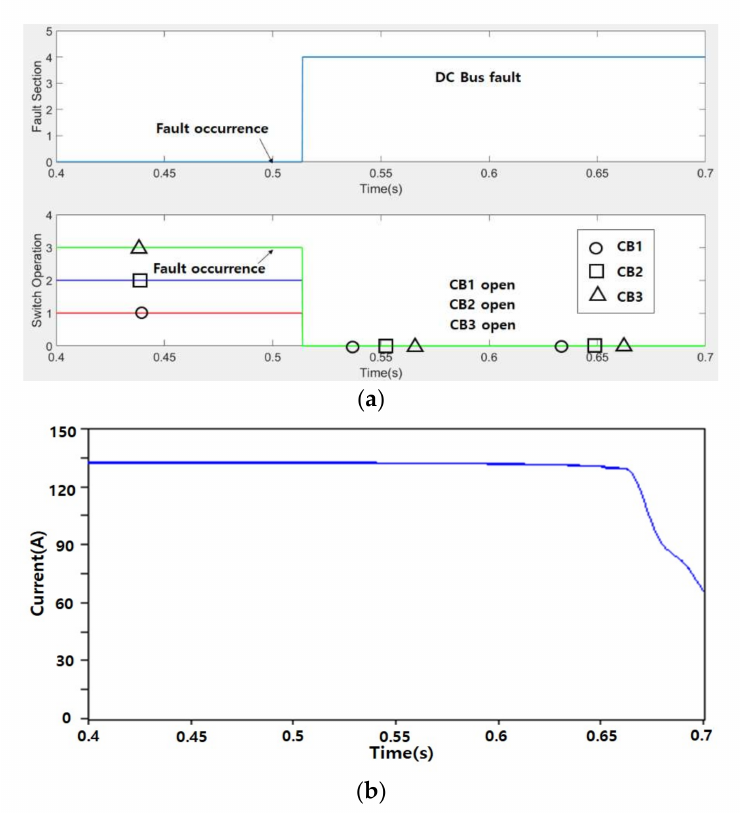
Figure 26. Simulation results of Case 12: ( a ) Fault section and CB operation and ( b ) Load